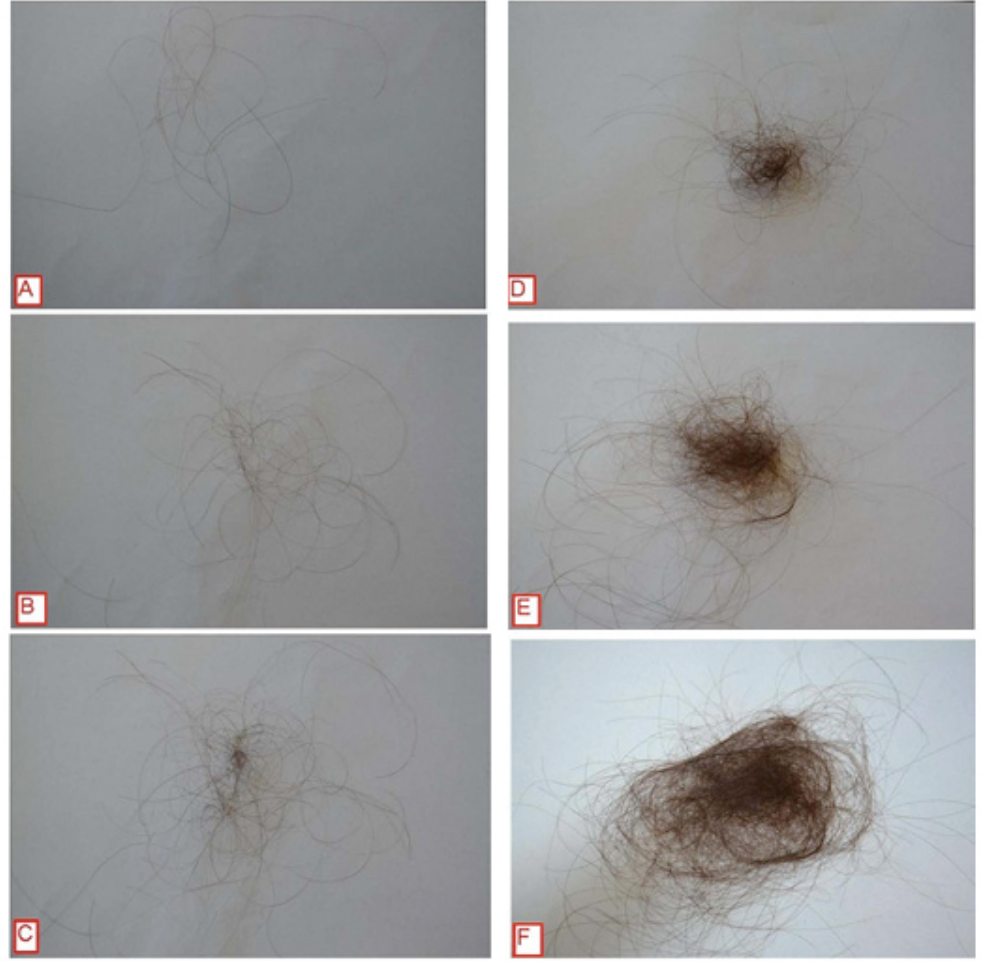
Figure 1. Hair shedding scale. Scores vary between 1 (minimal shedding) to 6 (copious hair shedding) 12